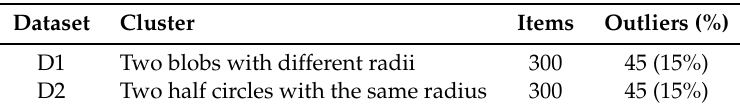
Table 2. Summary of synthetic datasets used in